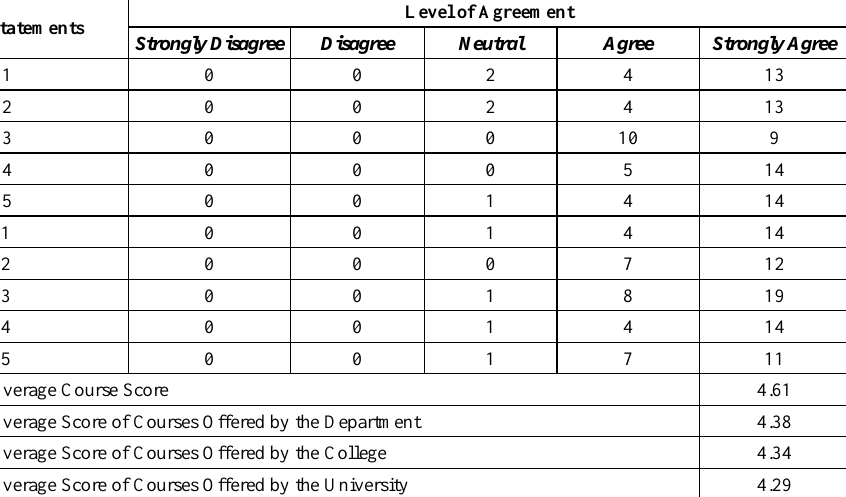
Table 7. Course evaluation for Statistical Software for Data